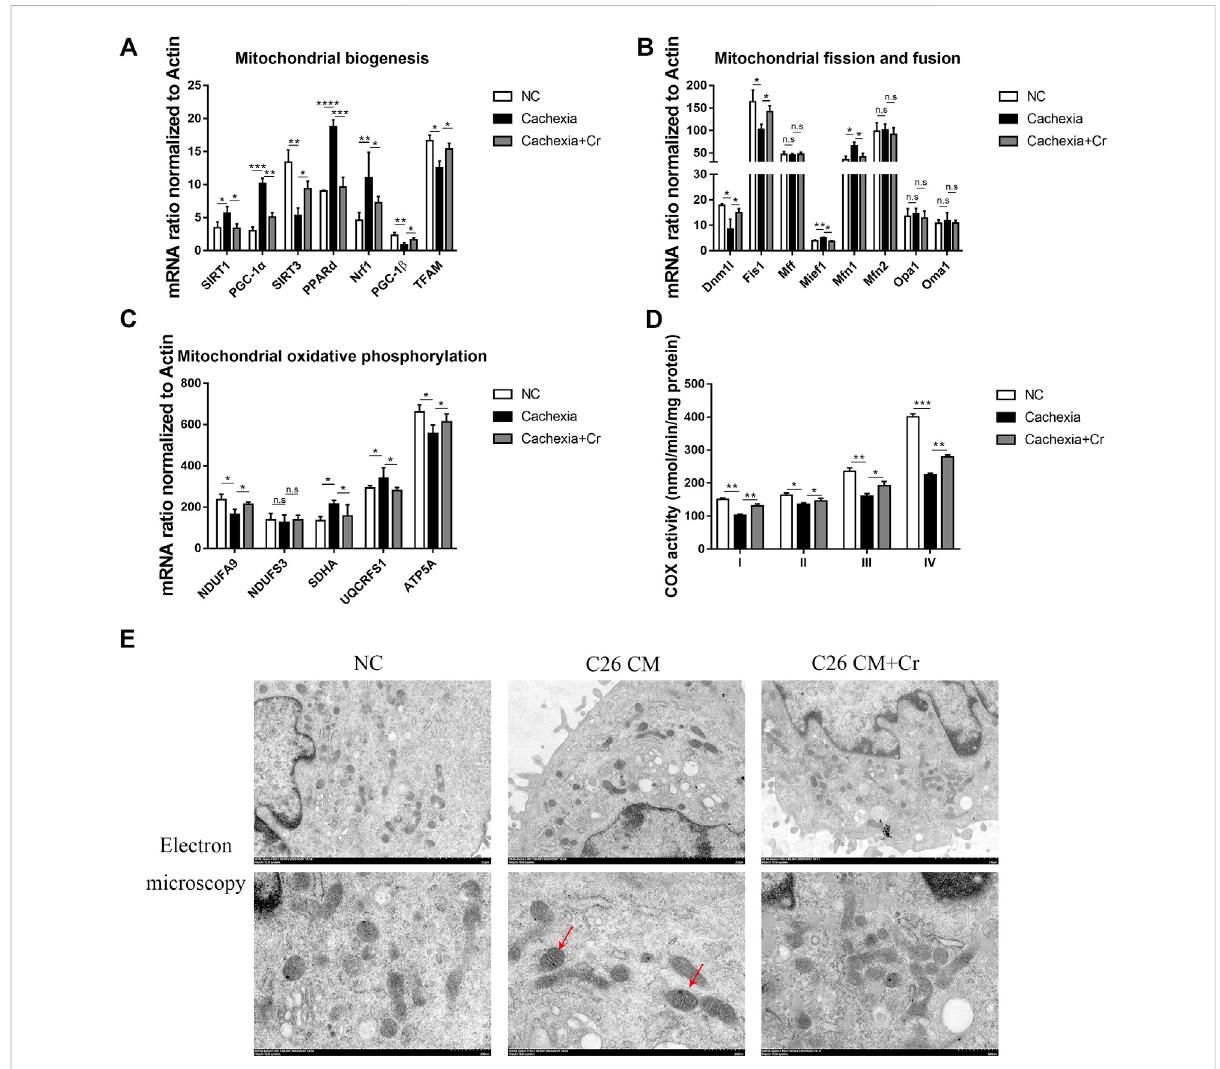
FIGURE 6 Supplementation with creatine improves mitochondrial function and morphology. (A – C) Total RNA was extracted from the skeletal muscle of the NC group, cachexia group and cachexia + Cr group, and the expression levels of genes involved in mitochondrial biogenesis, mitochondrial fi ssion and fusion, and mitochondrial oxidative phosphorylation in muscle were measured by real-time PCR. Data are expressed as the mean ± SD, * p < 0.05,** p < 0.01,*** p < 0.001,**** p < 0.0001, n =6. (D) ActivitiesofmitochondrialcomplexesI-IVinthemuscleofthethreemousegroups. (E) Imagesof mitochondrial structure were takenby transmission electronmicroscopy. The red arrows point to structurally abnormal